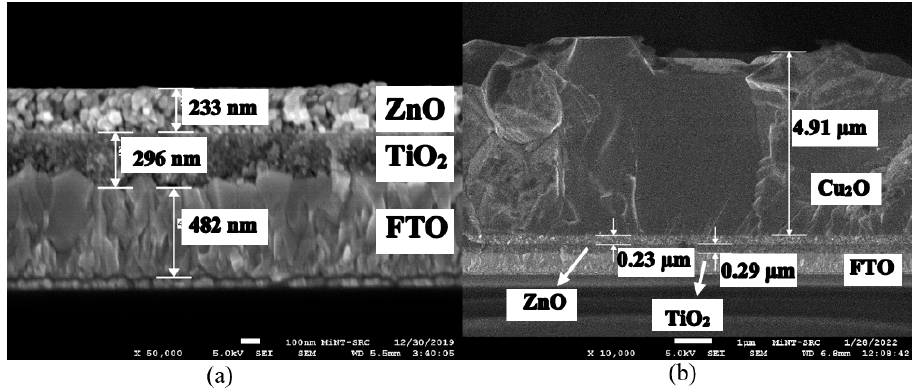
Figure 10. Cross-sectional images ( a ) before and ( b ) after stacking of p-Cu 2 O onto the n-TiO 2 /ZnO bilayer thin film.